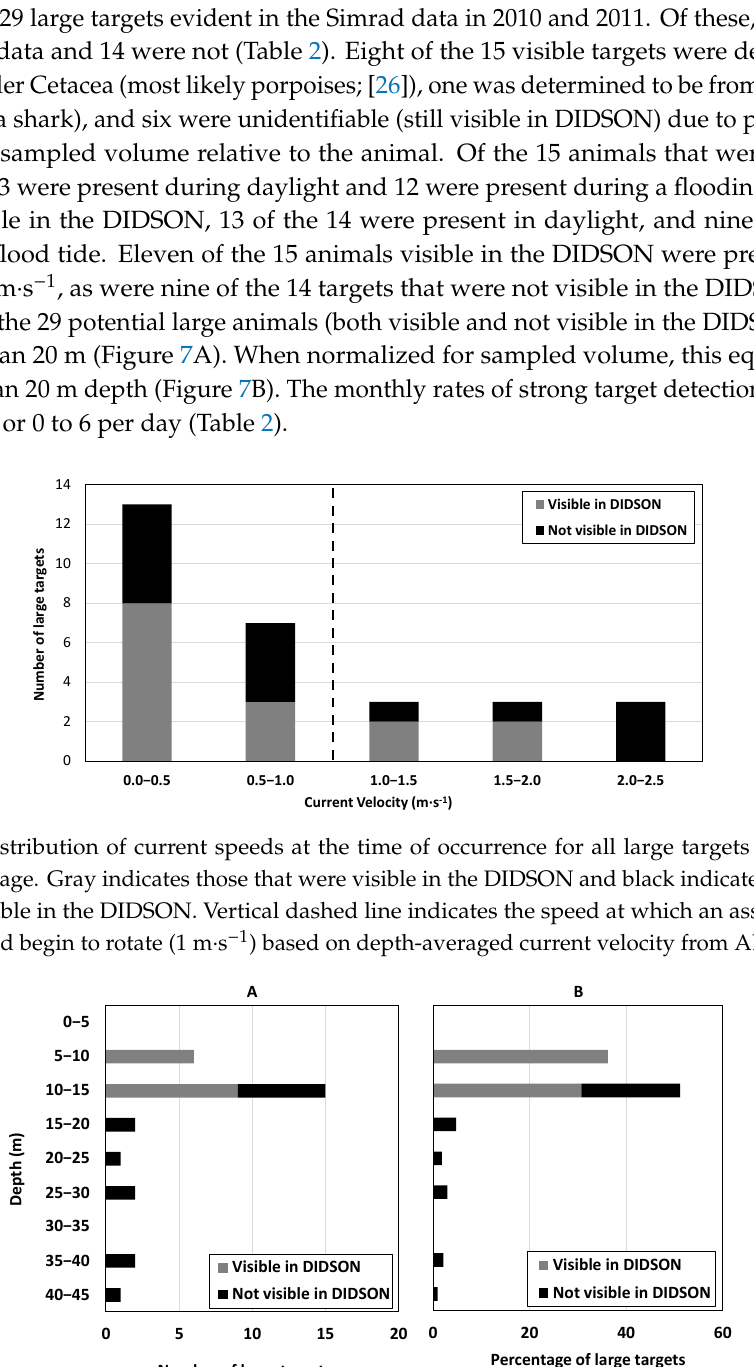
Figure 7. ( A ) Vertical distribution of all potential large animals detected in Western Passage. Gray indicates those that were visible in the DIDSON and black indicates those that were not visible in the DIDSON; ( B ) Vertical distribution of all potential large animals detected in Western Passage, normalized for acoustic beam width that increases with range. Gray indicates those that were visible in the DIDSON and black indicates those that were not visible in the DIDSON. Table 2. All detections of strong acoustic targets with TS greater than − 30 dB re 1 m 2 and less than 1 m in height in the Simrad data. When a valid length measurement was not possible, a dash was entered. Each survey month represents a single 24 ‐ h survey.